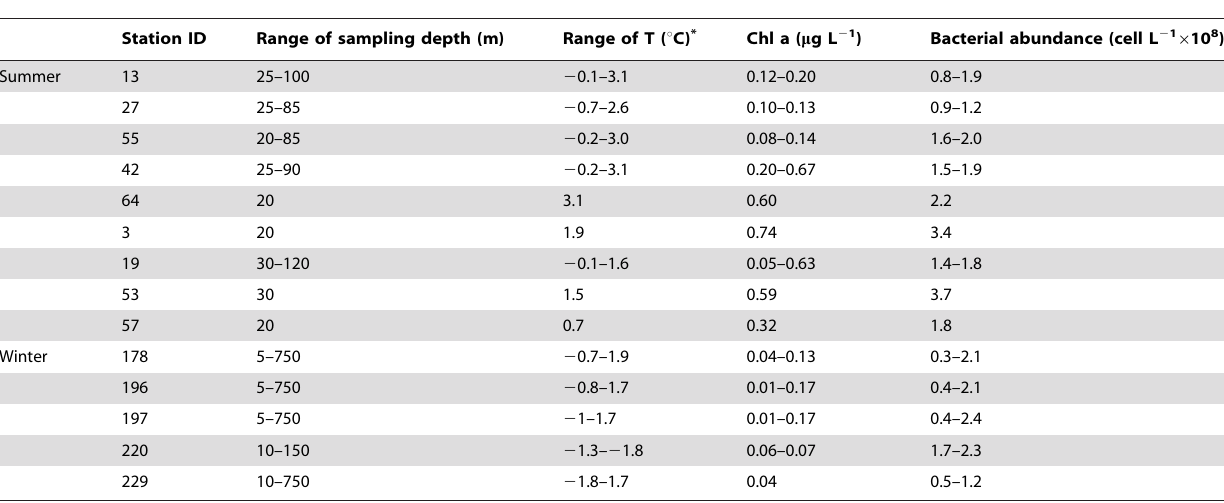
Table 3. List and parameters of stations sampled for bacterial community analysis.